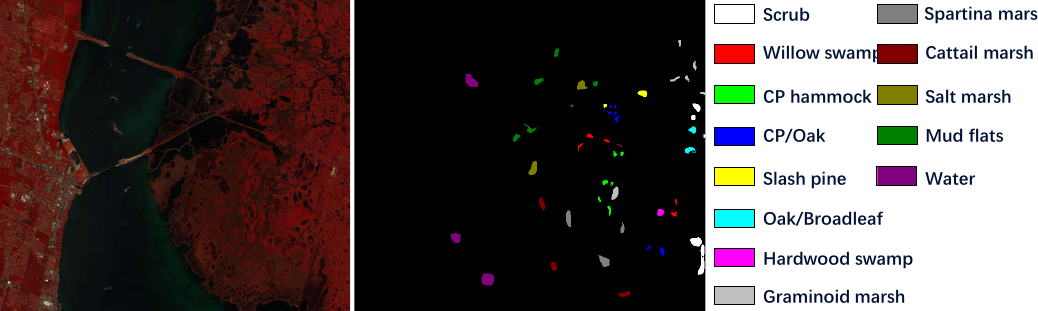
Figure 5. KSC dataset description. The false-color image is generated from spectral band 56, 28, 5 and the ground truth map together with the respective classes are